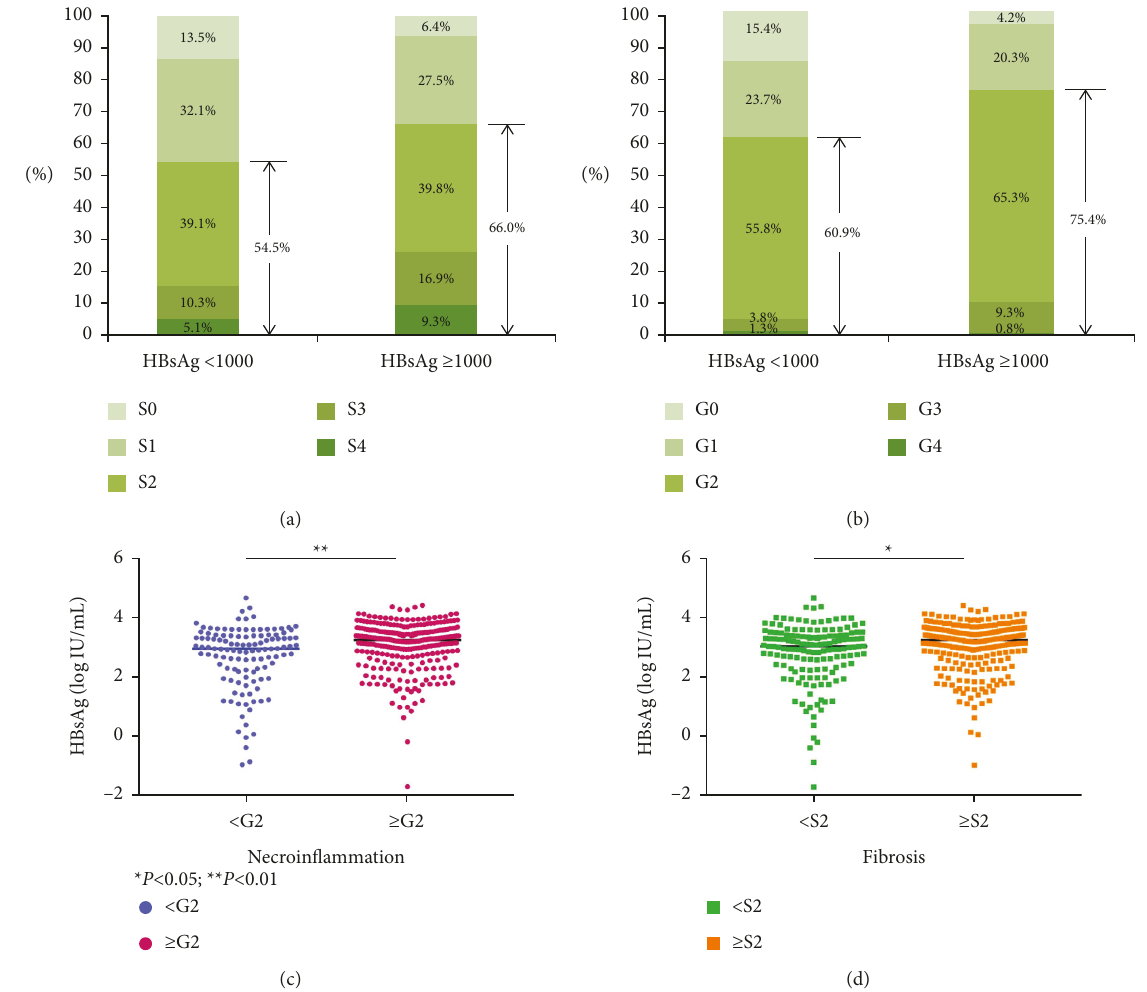
Figure 2: Relationship of HBsAg with liver necroinflammation and fibrosis. Table 2: Multivariate analysis of clinical parameters independently associated with significant histological abnormalities.